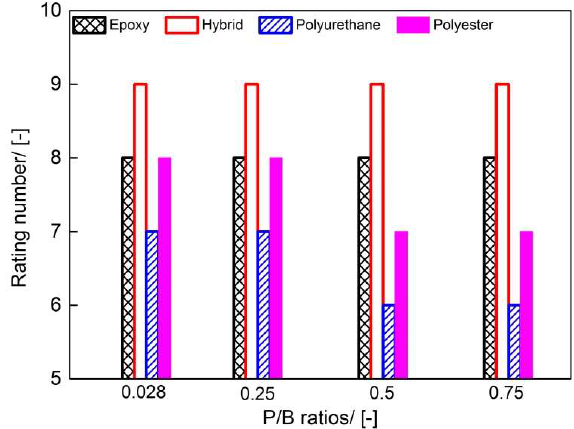
Figure 9. Rating number of failure at scribe of formulations with different resins and P/Bs after 1000 h of salt spray test.